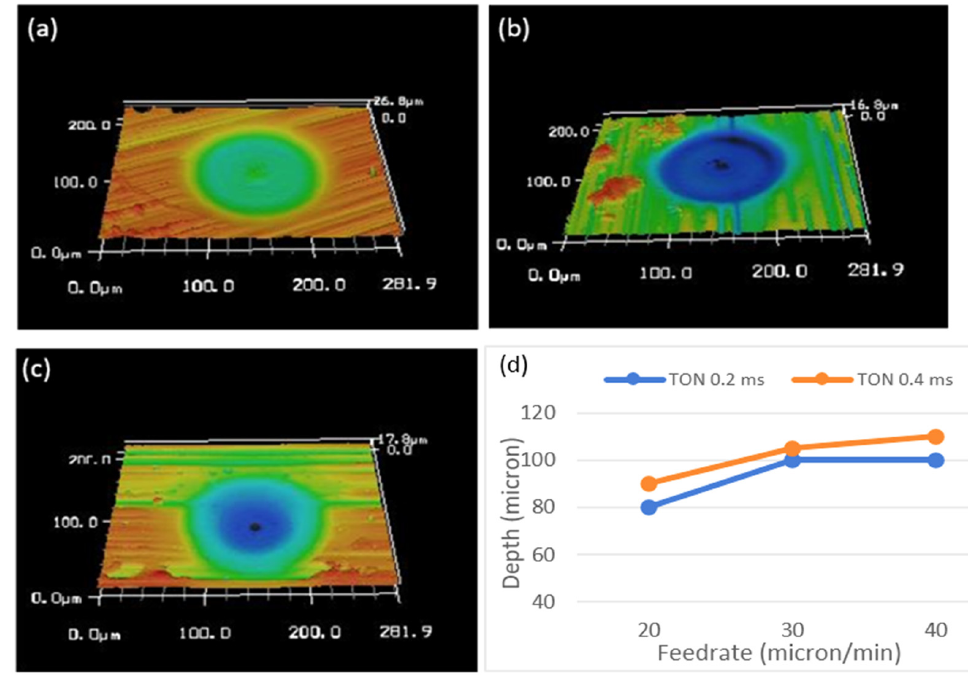
Figure 9. ECM drilling with T ON 0.2 ms, and various feed rate of ( a ) 20 µ m/min, ( b ) 30 µ m/ min, ( c ) 40 µ m/ min. ( d ) Machined depth vs. the feed rate conditions.